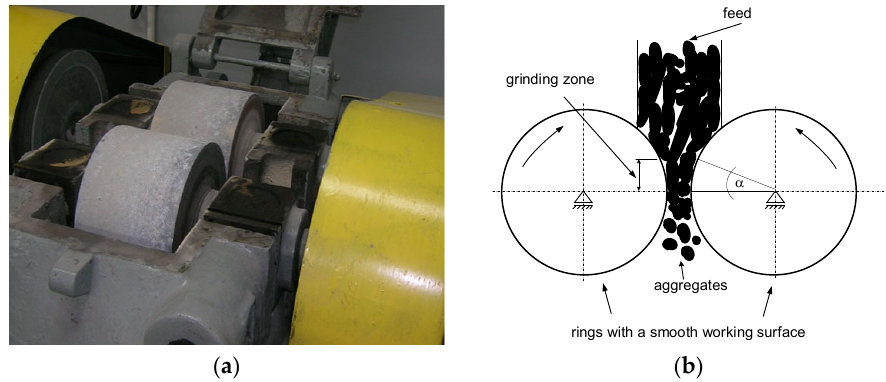
Figure 2. Laboratory ‐ scale roll crusher ( a ) and crusher layout ( b ).